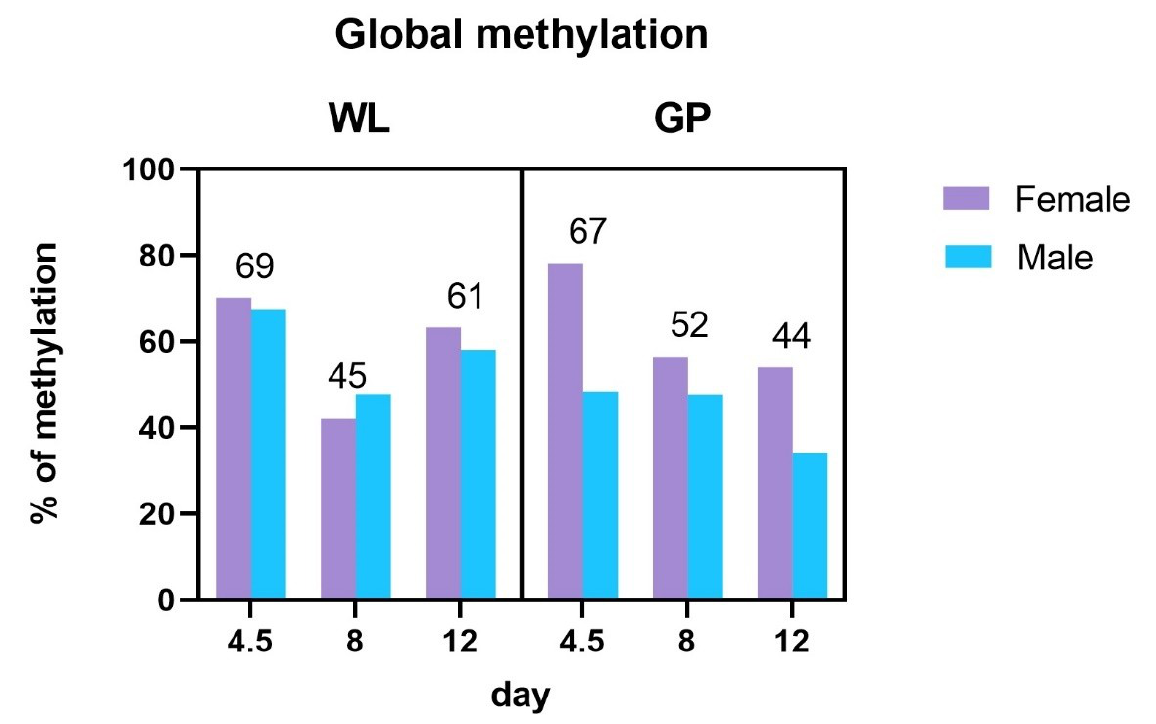
Figure 5. Global methylation levels (%) in three stages of embryonic development (days 4.5, 8, and 12) of two chicken breeds: WL and GP and two sexes (male and female). Table 2. Statistically significant gene expression changes detected on the microarray (GeneSpring software) in particular points of embryonic development of two chicken breeds—WL and